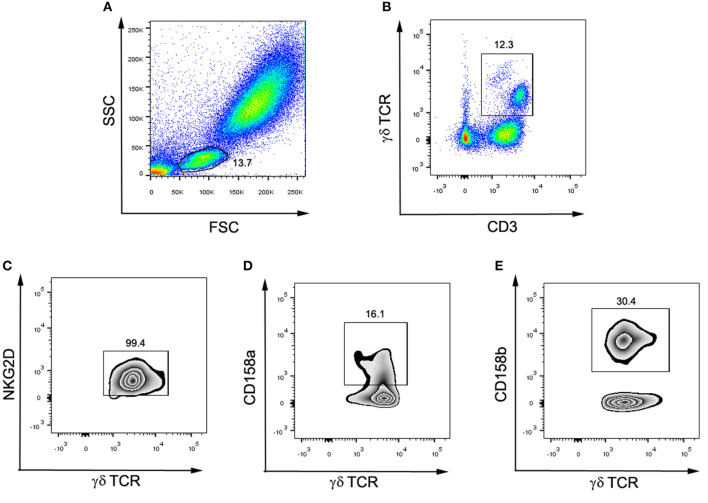
Flow cytometry gating strategy for surface markers and γδ-T cell subsets. (A) The lymphocytes were gated by FSC and SSC. (B) CD3+ γδ TCR+ cells were defined as γδ-T cells. (C) Among γδ-T cells, NKG2D+γδ TCR+ were defined as NKG2D+ γδ-T cells. (D) Among γδ-T cells, CD158a+γδ TCR+ were defined as CD158a+ γδ-T cells. (E) Among γδ-T cells, CD158b+γδ TCR+ were defined as CD158b+ γδ-T cells.